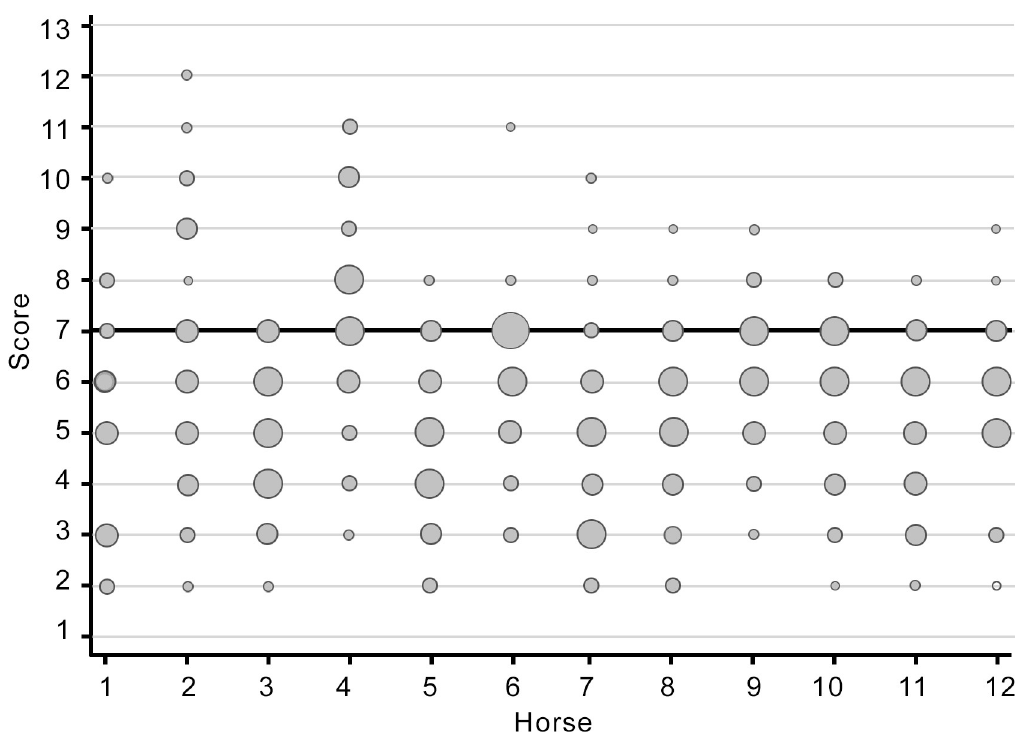
inter-rater agreement (ICC = 0.179). The size of dots illustrates the number of